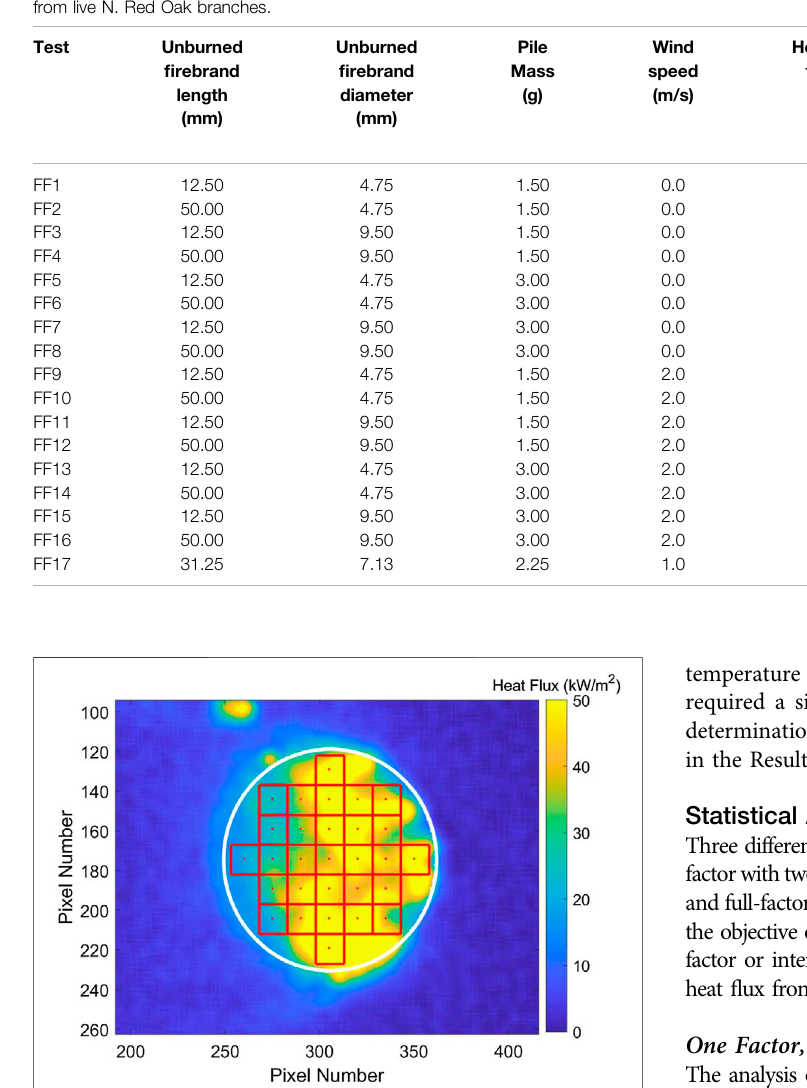
FIGURE 3 | 6.6 mm × 6.75 mm grids (shown in red) lying totally within the bounds of the 50 mm circular pile (shown in